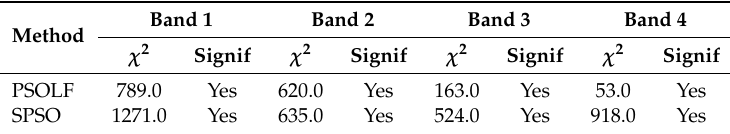
Table 7. Statistical significance of improvement of accuracy of the proposed LIPSO using McNemar’s Test [52] on Itezhi Tezhi Dataset. χ 2 values with one degree of freedom and 95% confidence, p < 0.05, Signif = significance.